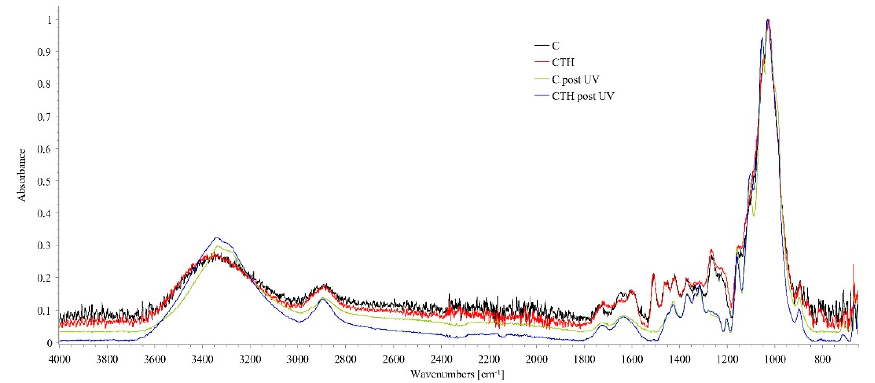
Figure 5. Comparison of FTIR spectra of C and CTH pre- and post-UV treatment. Only the fingerprint region of the FTIR spectra of C and CTH, pre and post UV, are highlighted in Figure 6 to better illustrate the impact of UV irradiation on wood surfaces.